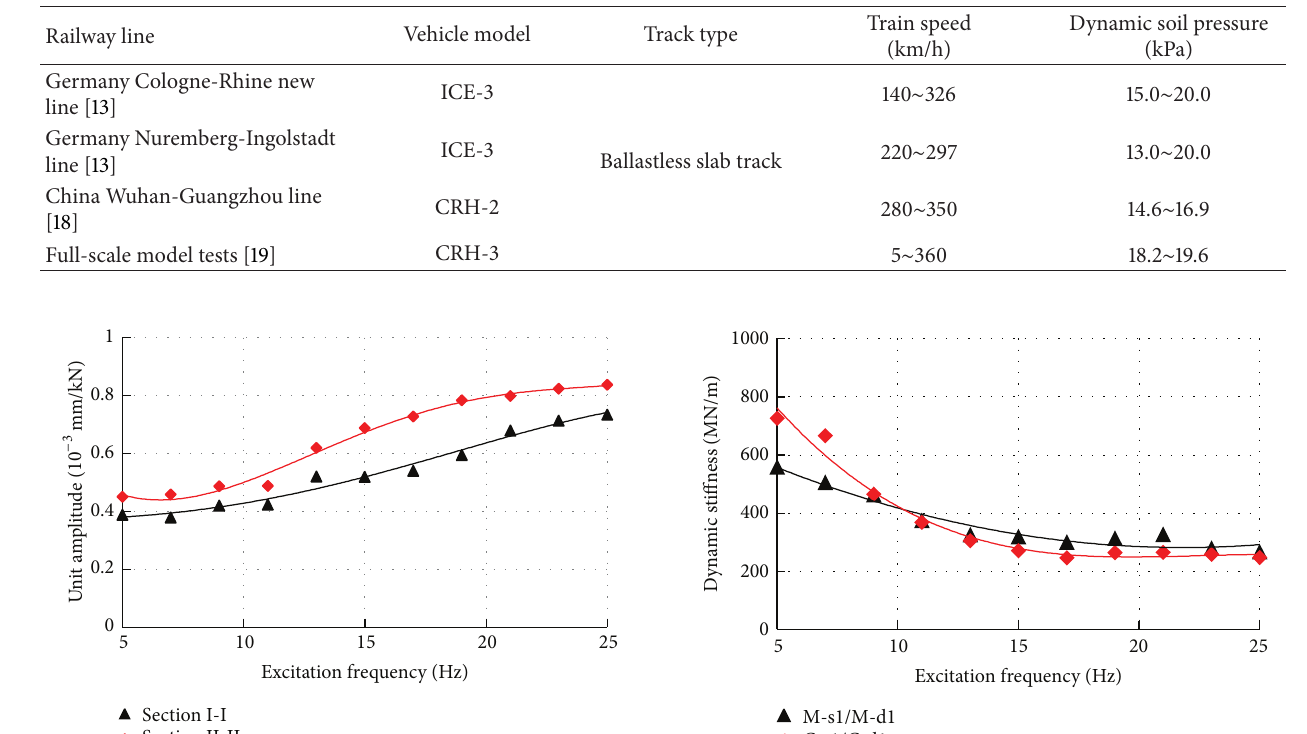
Table 3: Dynamic soil stress measured at subgrade bed surface.